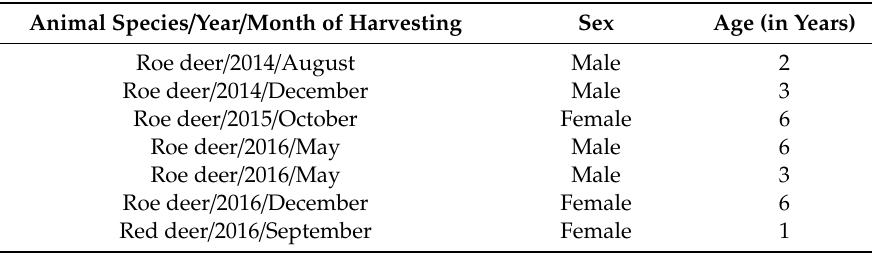
Figure 1. Geographical locations of the collection of roe and red deer samples from fibropapilloma tissues that tested positive for the presence of papillomavirus (PV). Table 1. Data of the investigated